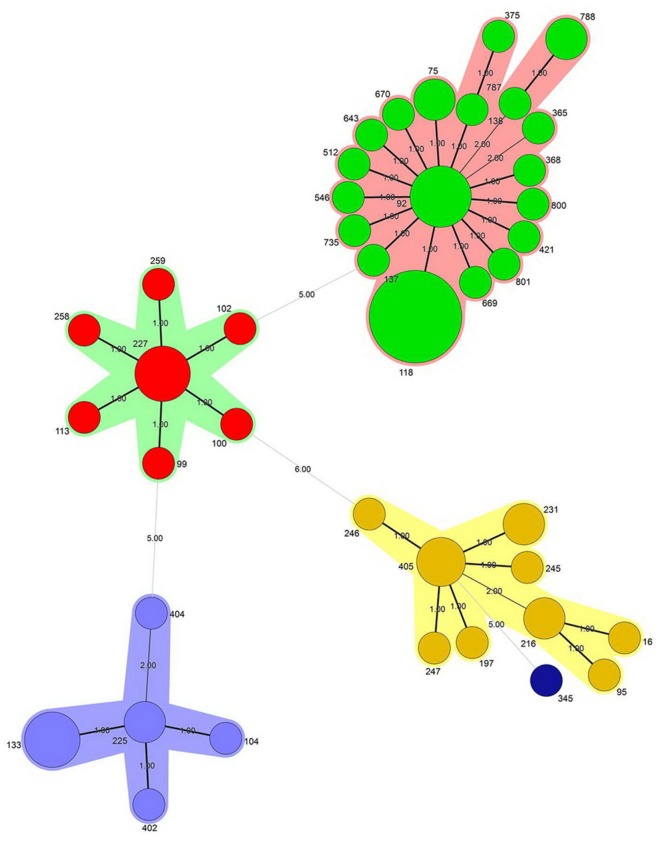
The minimum spanning tree (MStree) was constructed using a categorical coefficient based on multilocus sequence typing (MLST) data. Each circle stands for a different sequence type (ST). The color of a circle and the line clustering the ST with the same color represents an identical ST. Size of the circle corresponds to the number of isolates. The width of the line reflects the genetic distance between ST (heavy and thin lines represent a difference in one allele and two or more alleles, respectively).